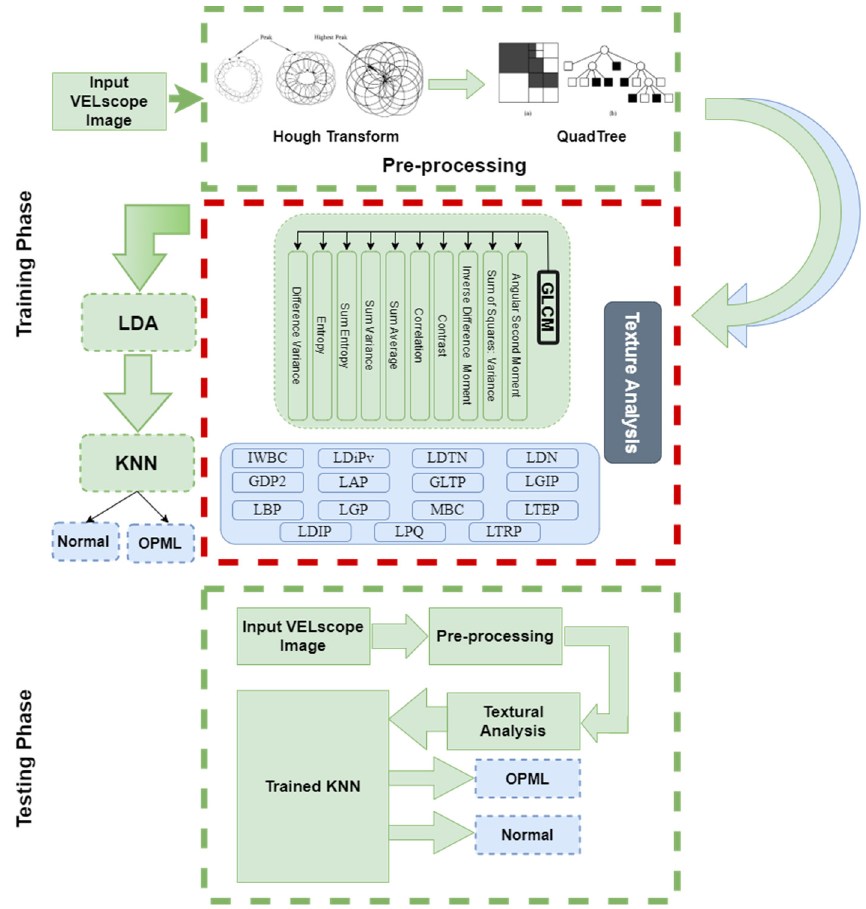
Figure 4. Flow chart of the textural analysis algorithm.